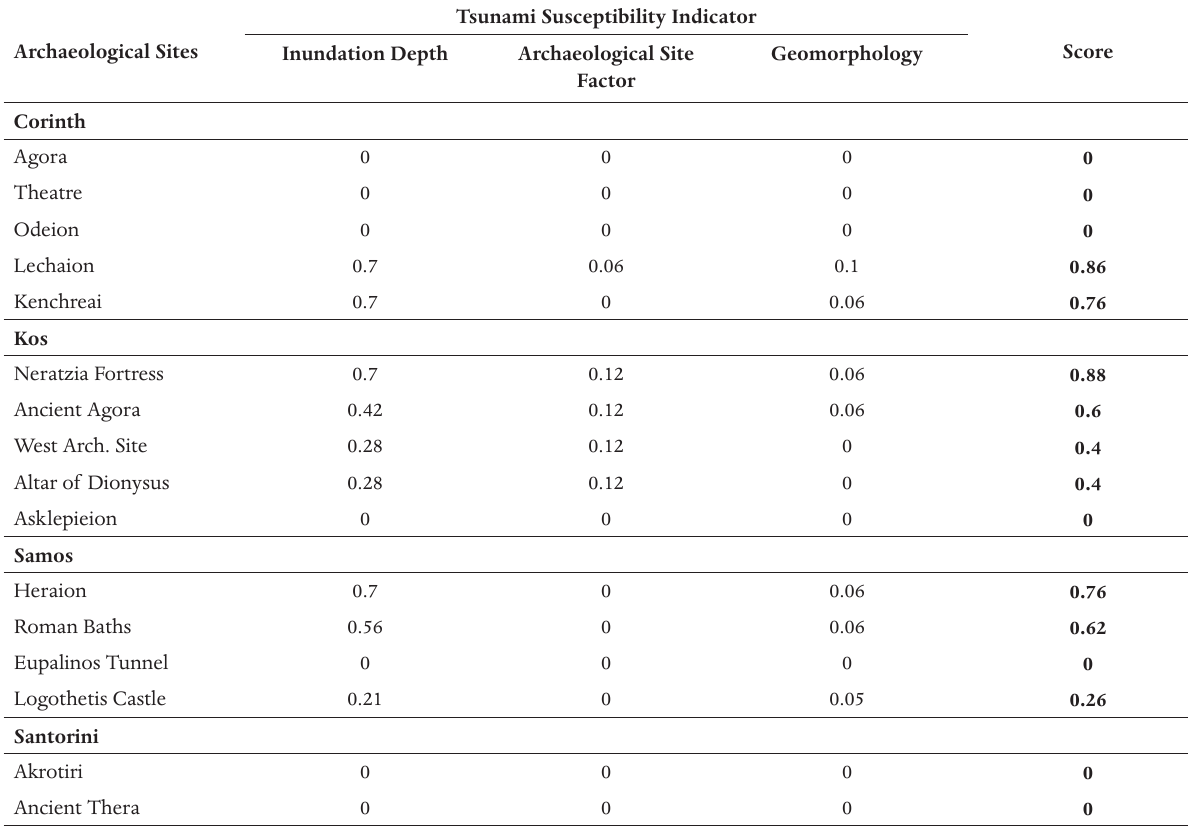
Table 3. Tsunami Susceptibility indicator weighted factors and scores for the archaeological sites under